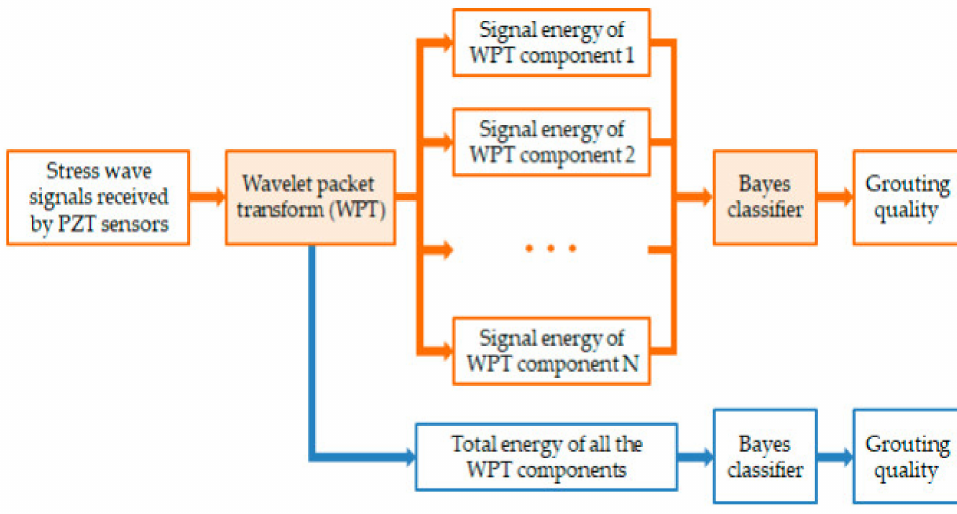
Figure 19. Overview of the proposed grouting quality evaluation method